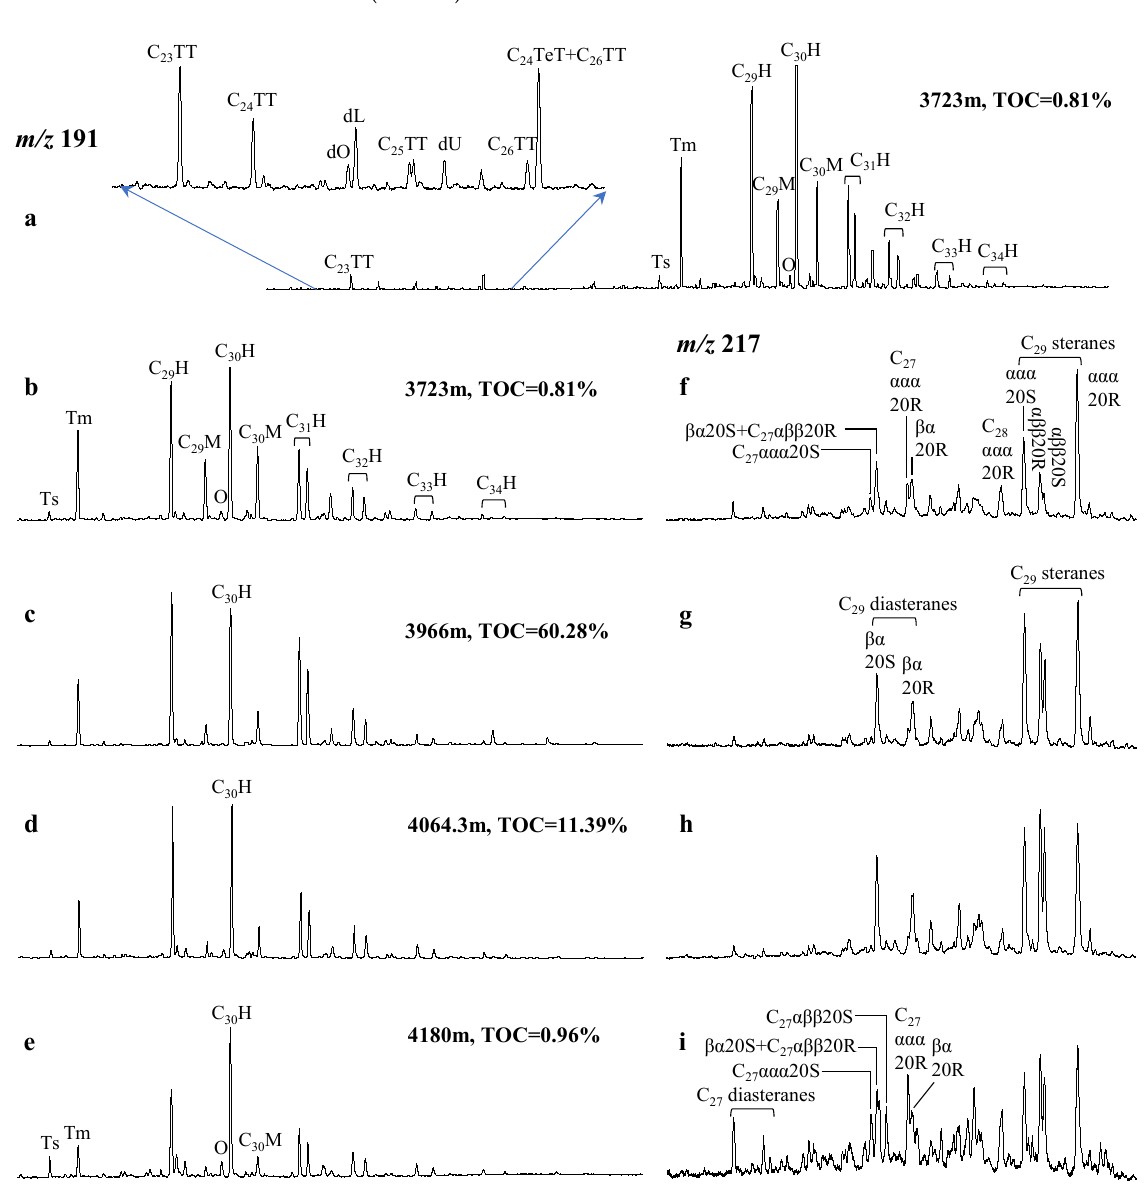
Figure 9. Partial m / z 191 ( a – e ) and 217 ( f – i ) mass chromatograms showing the distribution of tricylic terpanes, pentacyclic triterpanes and steranes. TT: tricyclic terpane; TeT: tetracyclic terpane; dO: 10 β (H)-des-A-oleanane, dL: 10 β (H)-des-A- lupane, dU: 10 β (H)-des-A-ursane; Ts: 18 α (H)-22,29,30-trinorneohopane; Tm: 17 α (H)-22,29,30-trinorhopane; O: oleanane, H: αβ -hopane; M: mortane ( βα -hopane).